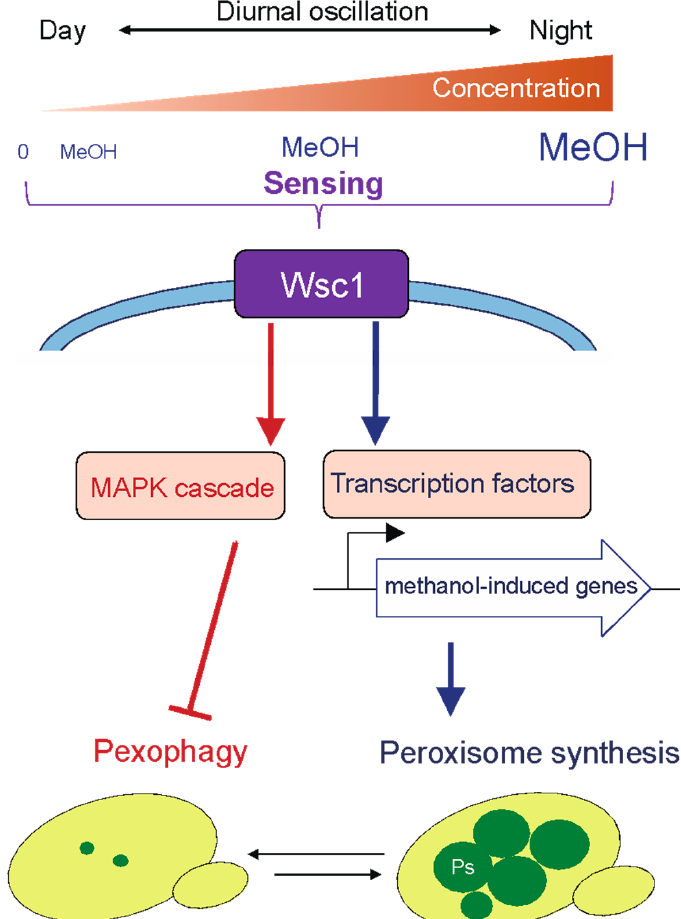
Figure 2. The cell-surface protein Wsc1 senses the methanol concentration in the phyllosphere and regulates peroxisome dynamics in methylotrophic yeast. Wsc1 senses a wide range of methanol concentrations that oscillate diurnally in the phyllosphere. A signal from Wsc1 is transmitted to the transcription factors, activating expression of methanol-induced genes followed by the development of peroxisomes. Under lower methanol concentrations and carbon source-depleted conditions, peroxisomes are degraded by pexophagy. Wsc1 and the downstream MAPK cascade repress pexophagy in the presence of methanol concentrations higher than 0.15%.